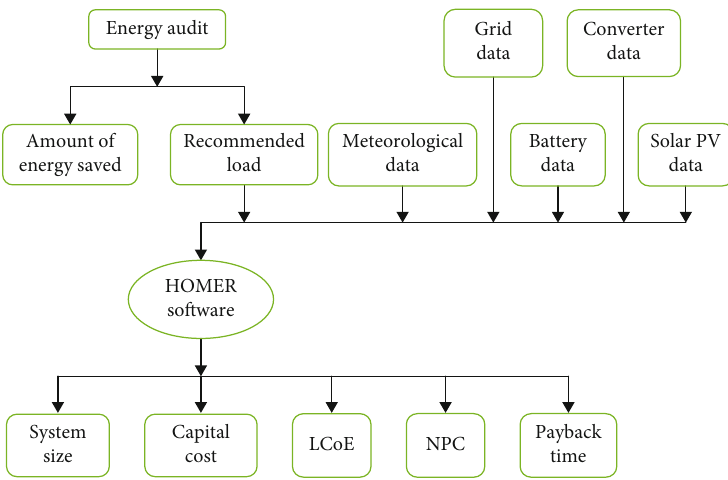
Figure 1: Summary of methodology for the